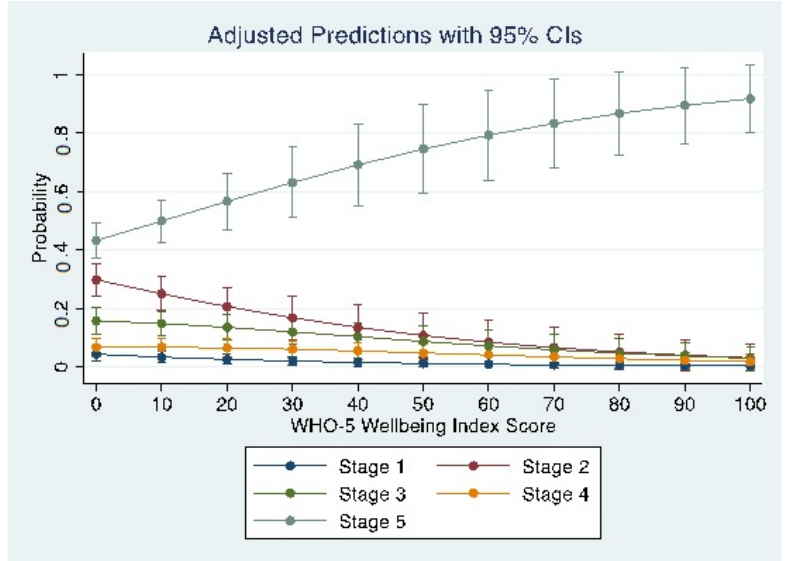
Figure 1. Predicted probabilities and 95% confidence intervals for each 10-point incremental increase in the percentage of maternal WHO-5 Well-Being Index scores for each stage of behaviour change. Table 2. Baseline maternal well ‐ being scores * at each stage of behaviour change. Values reported are mean percentage scores (standard deviation; SD).